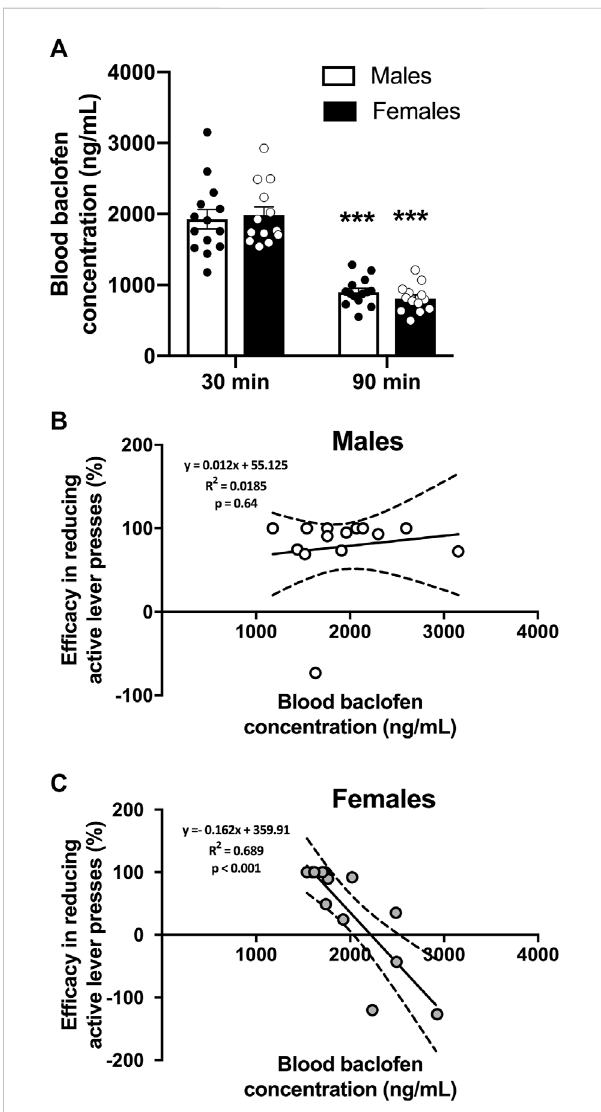
FIGURE 3 Blood RS(±)-Baclofen concentrations and correlation to its ef fi cacy. (A) Blood samples were collected 30 and 90 min after the i.p. administration of a dose of 1.5 mg/kg of RS(±)-Baclofen. Results are expressed as Mean ± SEM blood Baclofen concentration in ng/mL. *** p < 0.001 vs. 30-min data within each sex. (B,C) Correlations between blood Baclofen concentration and ef fi cacy in reducing alcohol operant self-administration in males (B) and females (C) . Blood Baclofen concentrations are expressed in ng/mL. Positive variationsindicateanef fi